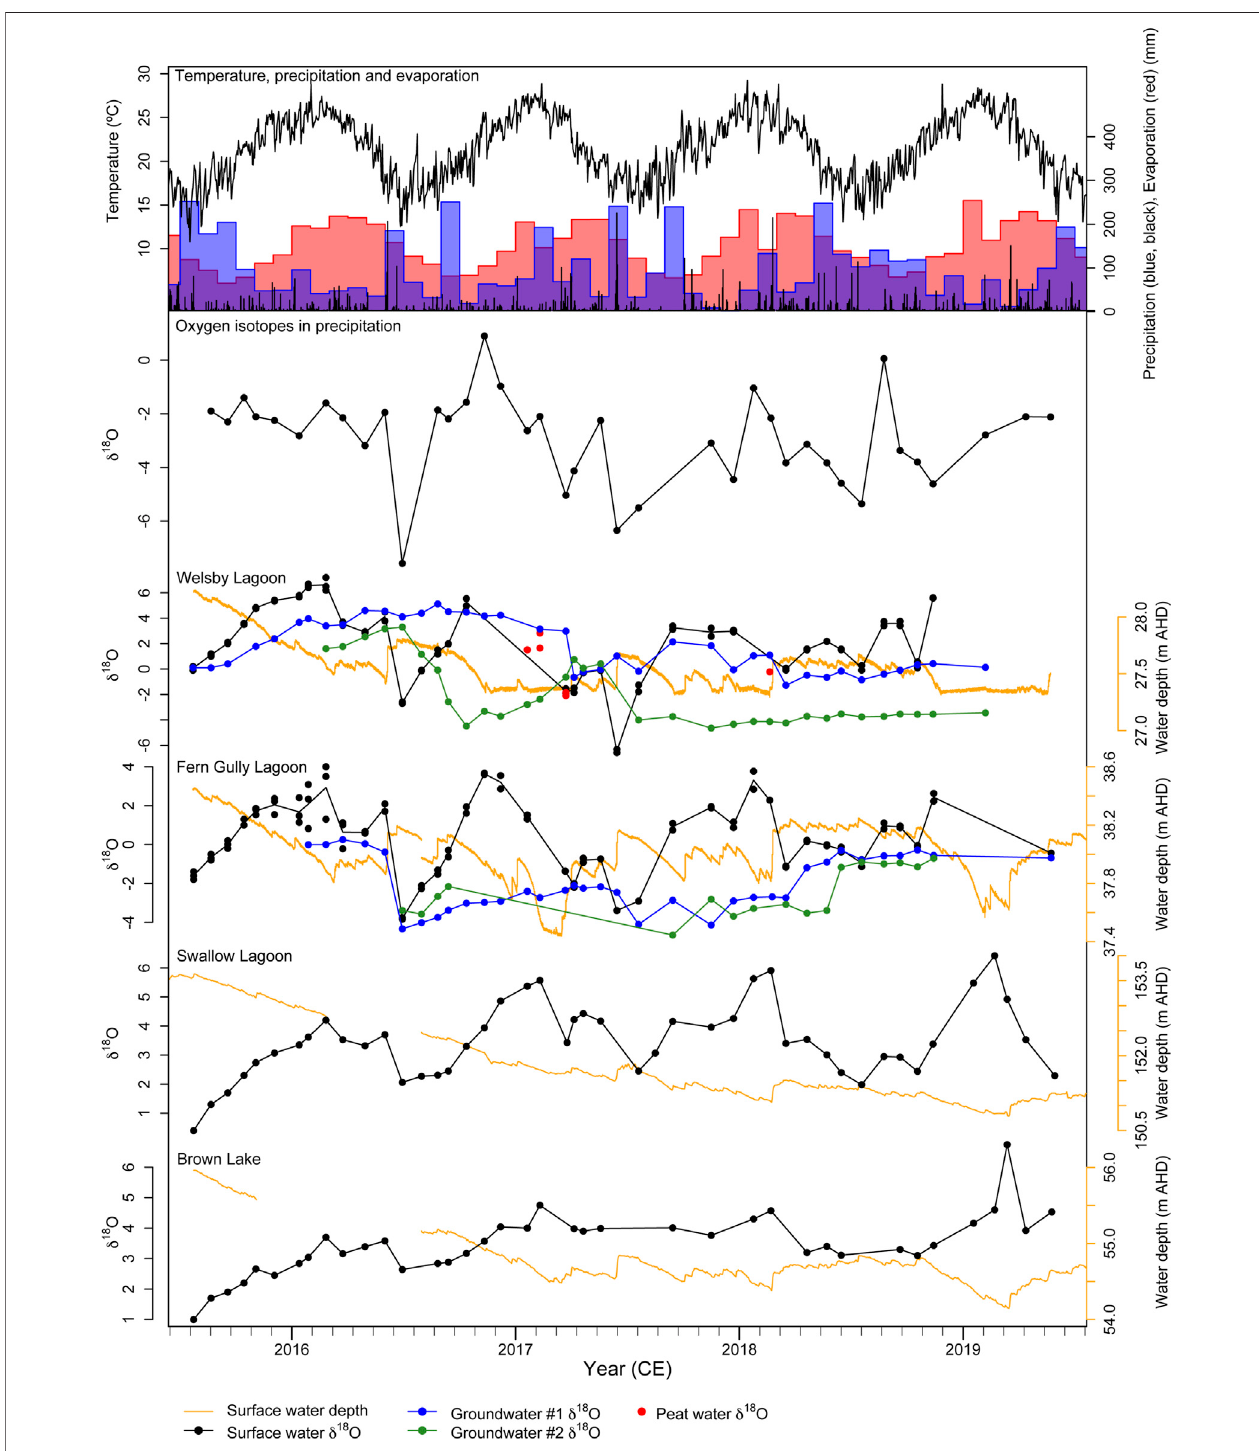
FIGURE4| Comparisonbetweenoxygenisotoperatiosofrainwater,surfacewatersandgroundwateratWelsbyLagoon,FernGullyLagoon,SwallowLagoonand Brown Lake. Climate data presented as in Figure 3 . Black points and lines indicate δ 18 O of rainwater (collected at Welsby Lagoon) or surface water at all sites. For Weslby and Fern Gully Lagoons, blue and green points and lines indicate the δ 18 O of groundwater at two monitoring bores at each site. Red points indicate the δ 18 O of “ peat water ”— i.e. sediment interstitial water collected when surface water levels had dropped beneath the wetland sediment surface.